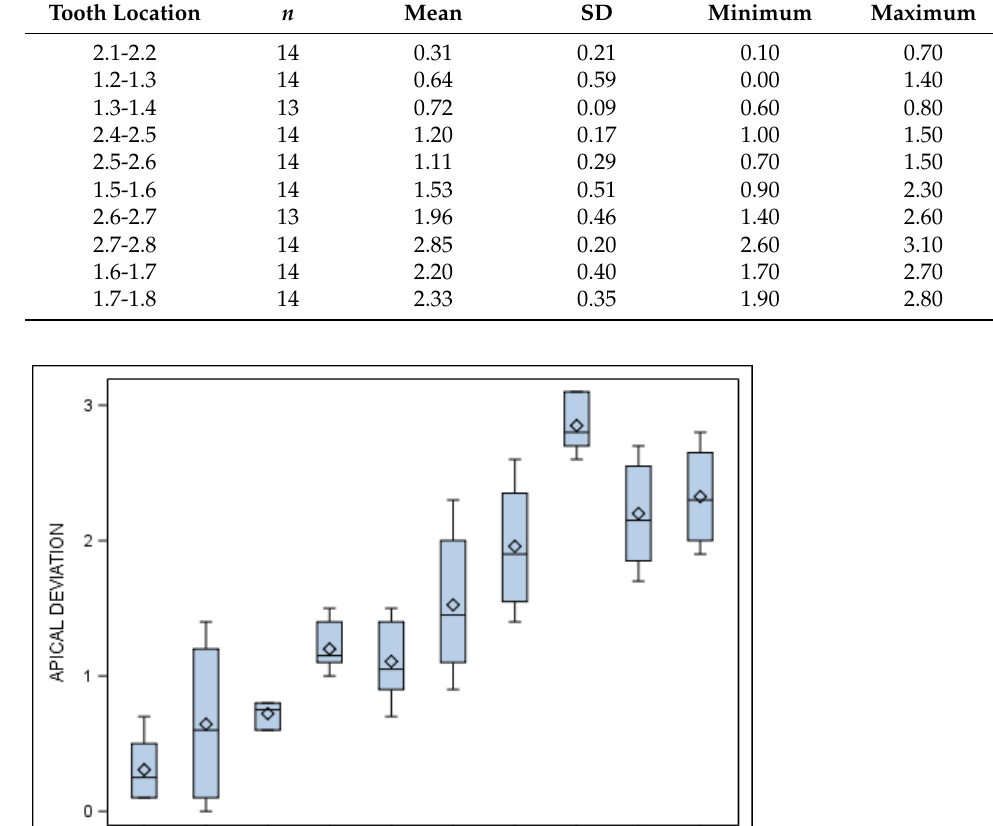
Table 5. Descriptive deviation values at apical end-point (mm) of the orthodontic micro-screws placed in the selected tooth positioning.